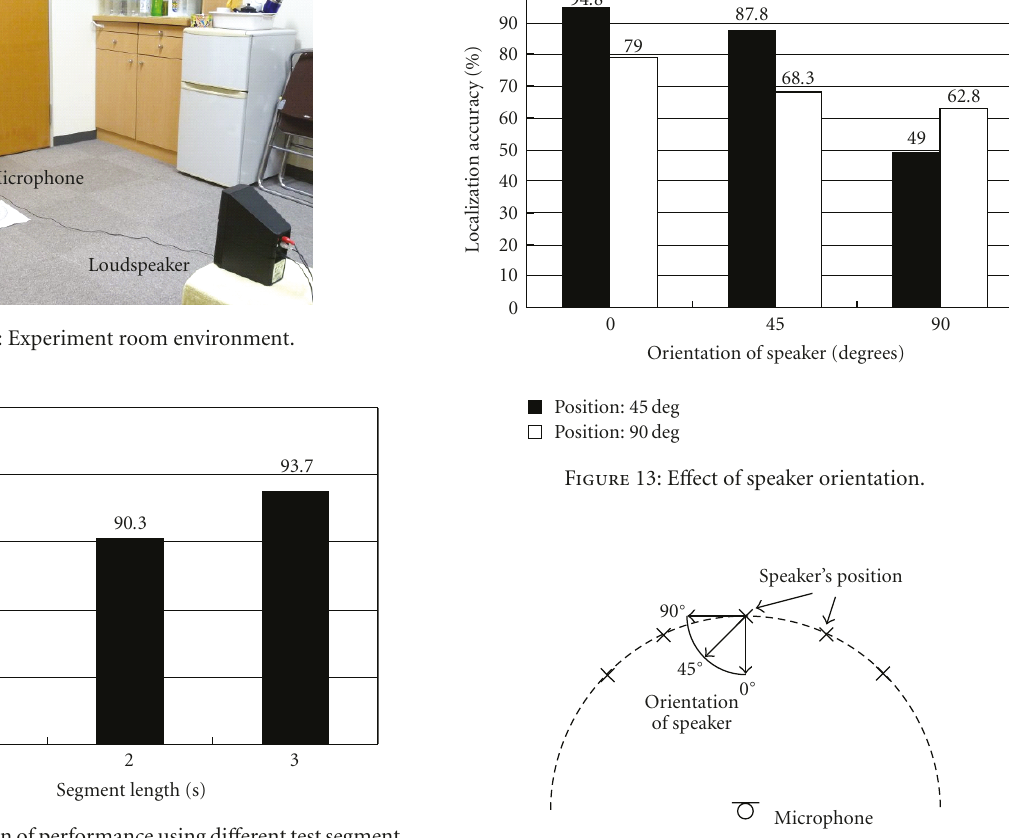
Figure 14: Speaker